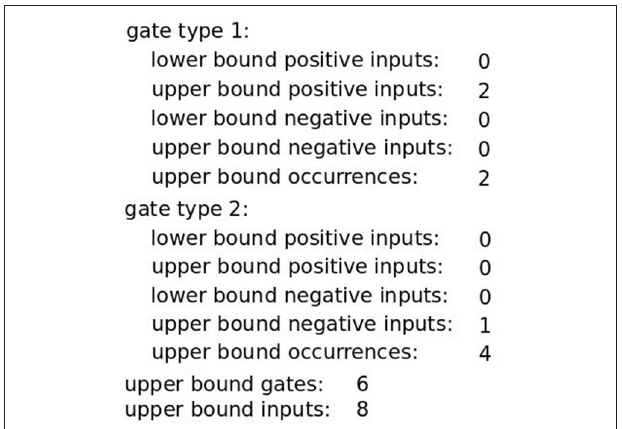
FIGURE 4 | A full set of core classifier constraints. Here, a classifier may consist of up to 6 gates with overall up to 8 inputs. Gates are either of Type 1 (OR gate) or Type 2 (NOT gate) where the first may have only non-negated inputs while the second may only be a single negated